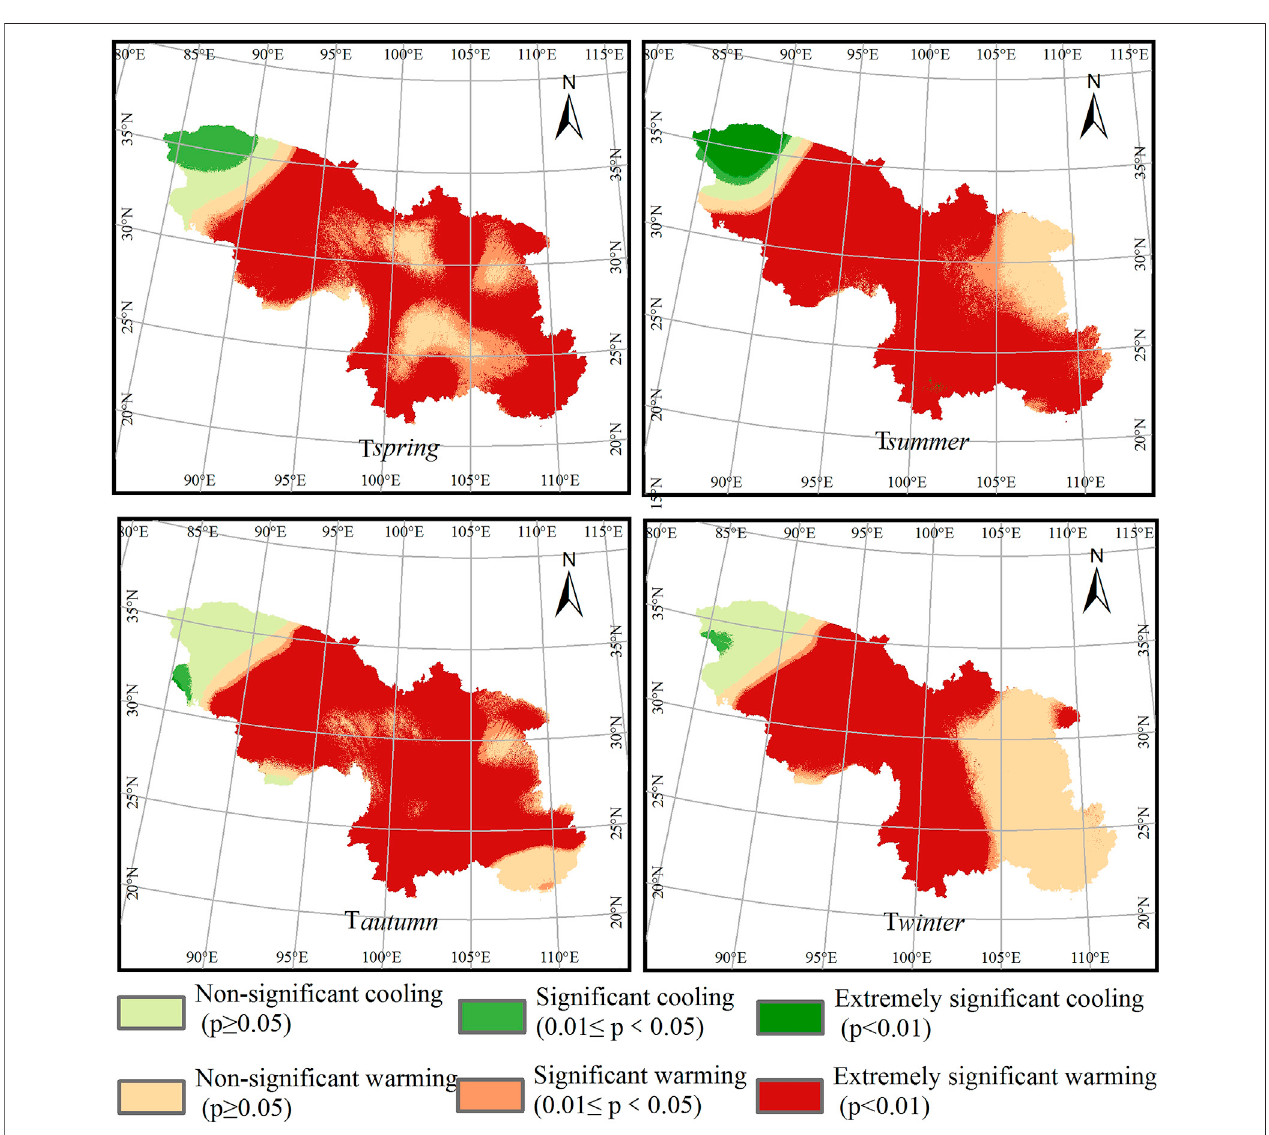
FIGURE 7 | Trends of NSAT over southwest China for the period 1969 – 2018. Panels (A – D) correspond to the mean spring, summer, autumn, and winter NSATs, respectively.